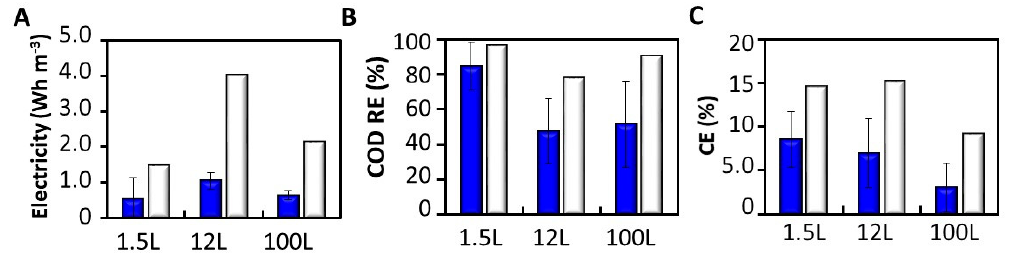
Figure 4. Comparison of ( A ) electricity generation, ( B ) COD RE, and ( C ) Coulombic efficiency in microbial fuel cells (MFCs) with different capacities. The blue and white bars show average and maximum electricity generation, respectively.